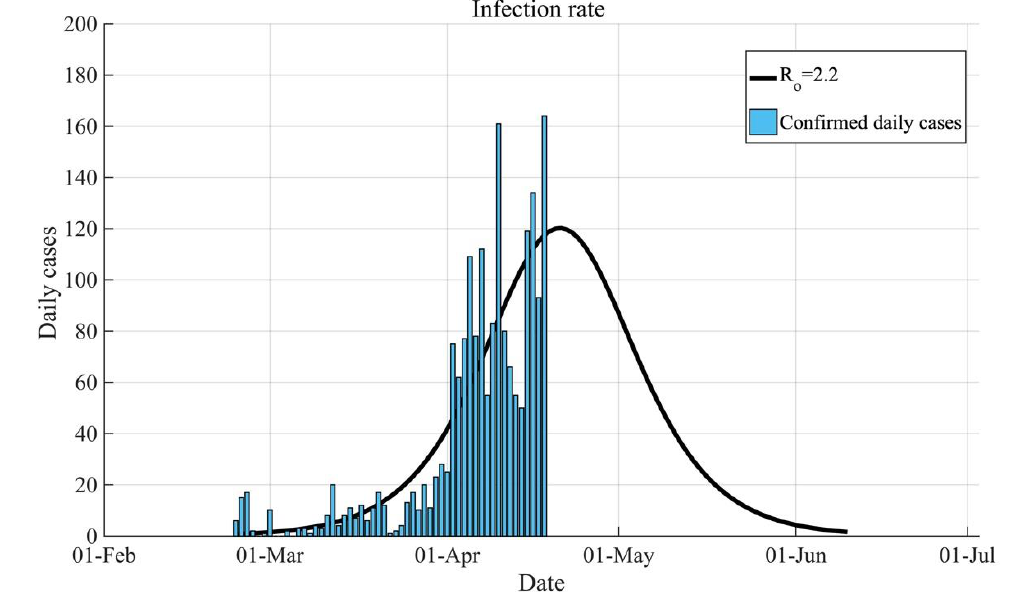
Figure 2. Confirmed infected daily cases and the prediction of infection rate in Kuwait. Table 3. Estimated simulation results of the logistics regression model.